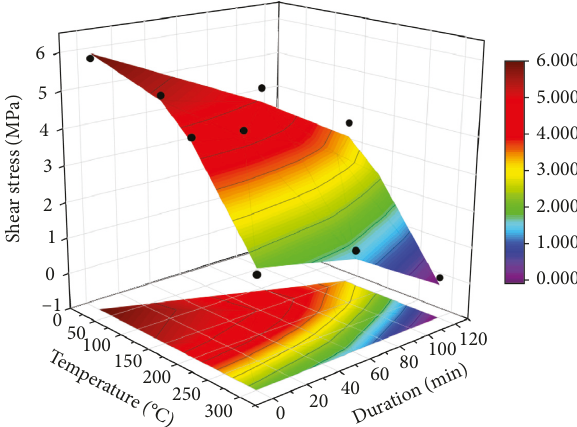
Figure 8: Simulation results of ultimate shear stress, heating temperature, and Table 3: Maximum temperature duration versus theoretical calculated ultimate shear stress.